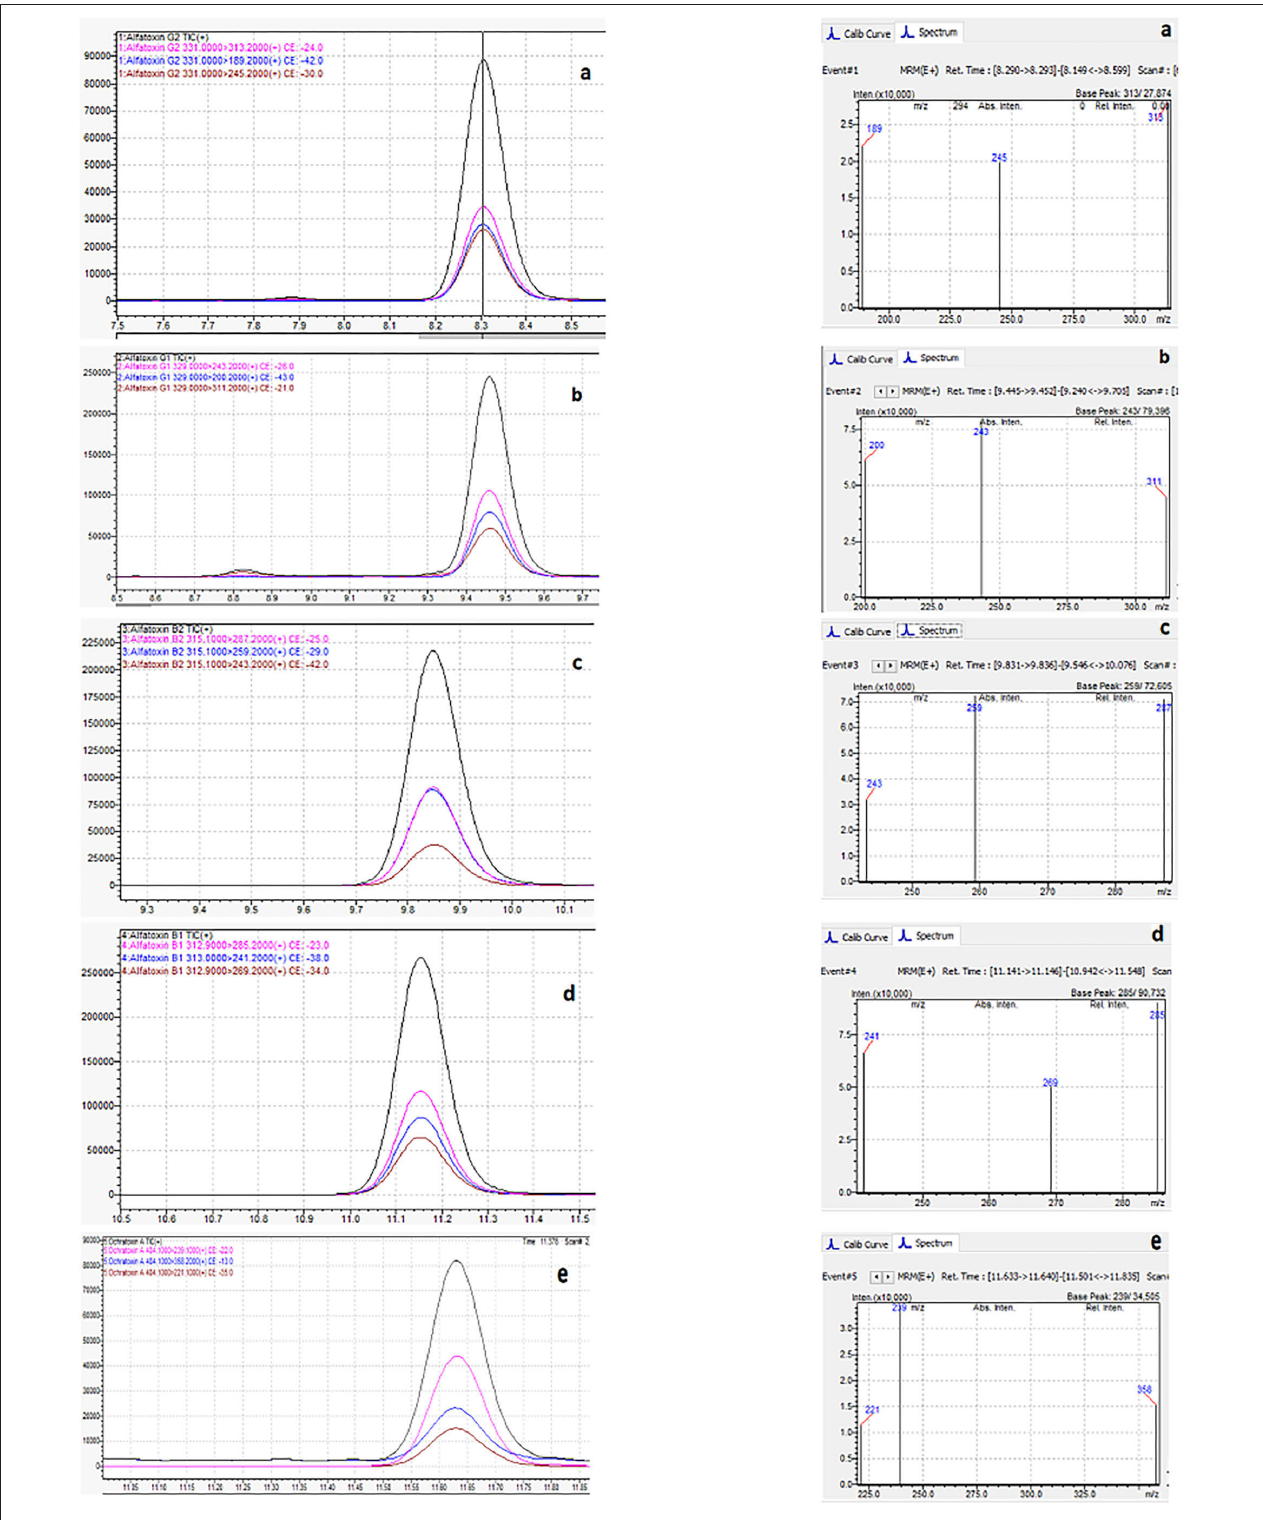
FIGURE 6 | Typical chromatogram and analyte transitions of the of AfG2 (a) , AfG1 (b) , AfB2 (c) , AfB1 (d) , OchA (e) .